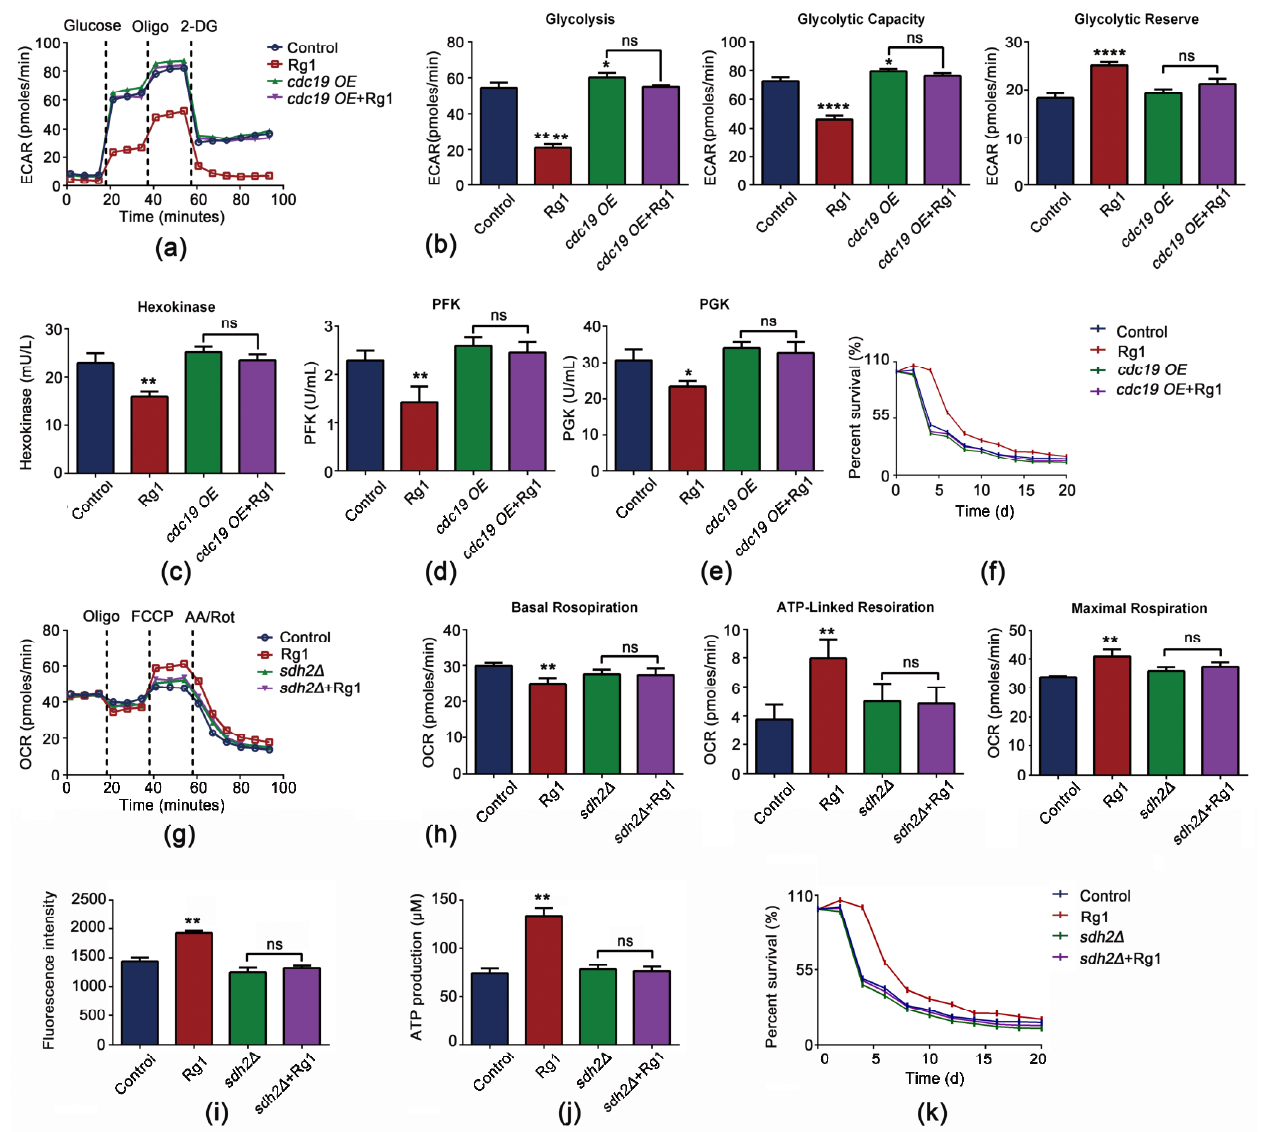
Figure 9. Antisenescence effects of Rg1 intervention on CDC19 -overexpressing ( cdc19 OE ) and SDH2 -deficient ( sdh2Δ ) strains of S. cerevisiae . ( a ) Graphical representation of ECAR measurements over time in S. cerevisiae strain BY4742 (the parental strain; Control and Rg1) and the cdc19 OE strain. ( b ) Calculation of representative functional parameters of glycolysis from ECAR curves. “Glycolysis” indicates the ECAR when glucose was injected; “Glycolytic Capacity” indicates the ECAR when oligomycin was injected; “Glycolytic Reserve” indicates the difference between Glycolysis and Glycolytic Capacity. Hexokinase ( c ), PFK ( d ), and PGK ( e ) enzyme activities. ( f ) Growth curves of S. cerevisiae BY4742 (Control and Rg1) and cdc19 OE strains. ( g ) Graphical representation of OCR measurements over time in strains BY4742 (Control and Rg1) and sdh2Δ . ( h ) Calculation of representative functional parameters of OXPHOS from OCR curves. “Basal Respiration” indicates the OCR in the absence of oligomycin; “ATP-linked Respiration” indicates the OCR after injection of oligomycin; “Maximal Respiration” indicates the OCR after injection of FCCP. MMP ( i ) and ATP ( j ) production levels in S. cerevisiae strains BY4742 (Control and Rg1) and sdh2Δ . ( k ) Growth curves of strains BY4742 (control and Rg1) and sdh2Δ . Data are expressed as the mean ± SD; n = 3. Compared with untreated controls, * p < 0.05, ** p < 0.01, **** p < 0.0001.